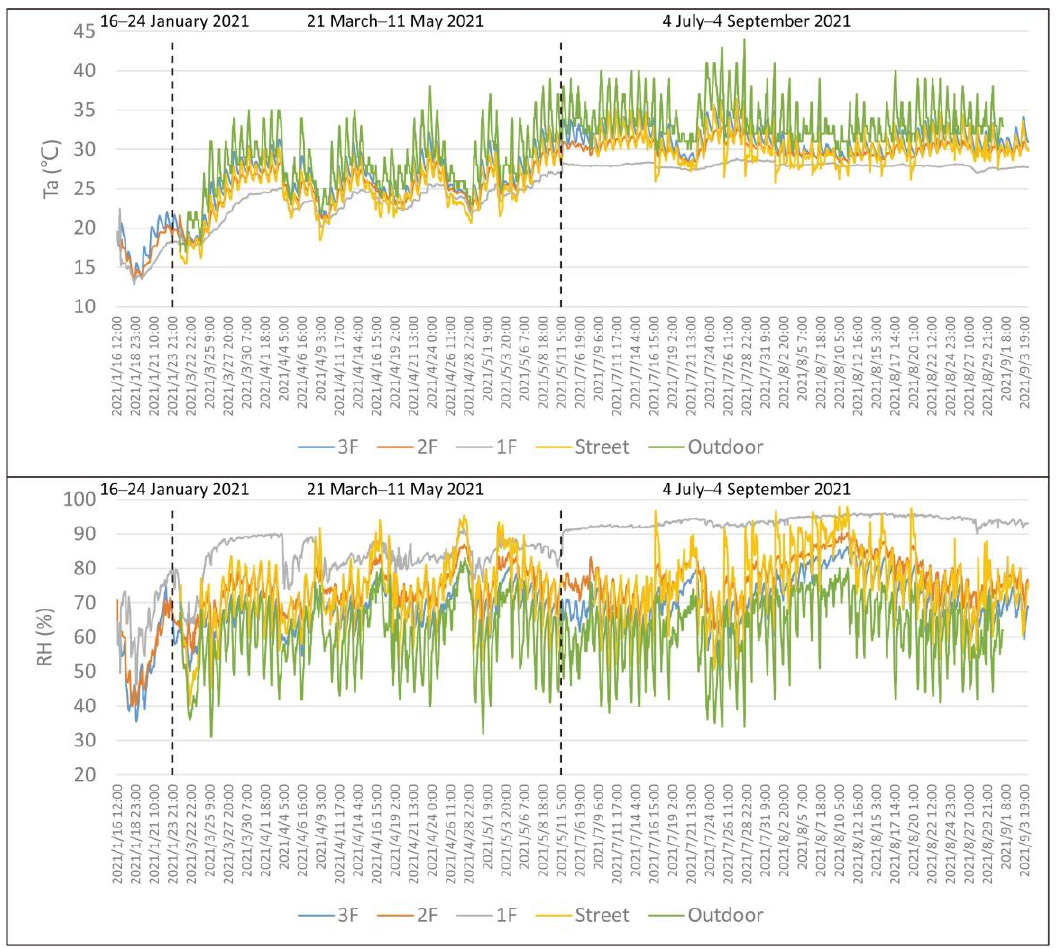
Buildings 2022 , 12 , x FOR PEER REVIEW Figure 14. Ta and RH measurement data (January – September 2021), drawn by the students. Figure 14. Ta and RH measurement data (January–September 2021), drawn by the students.